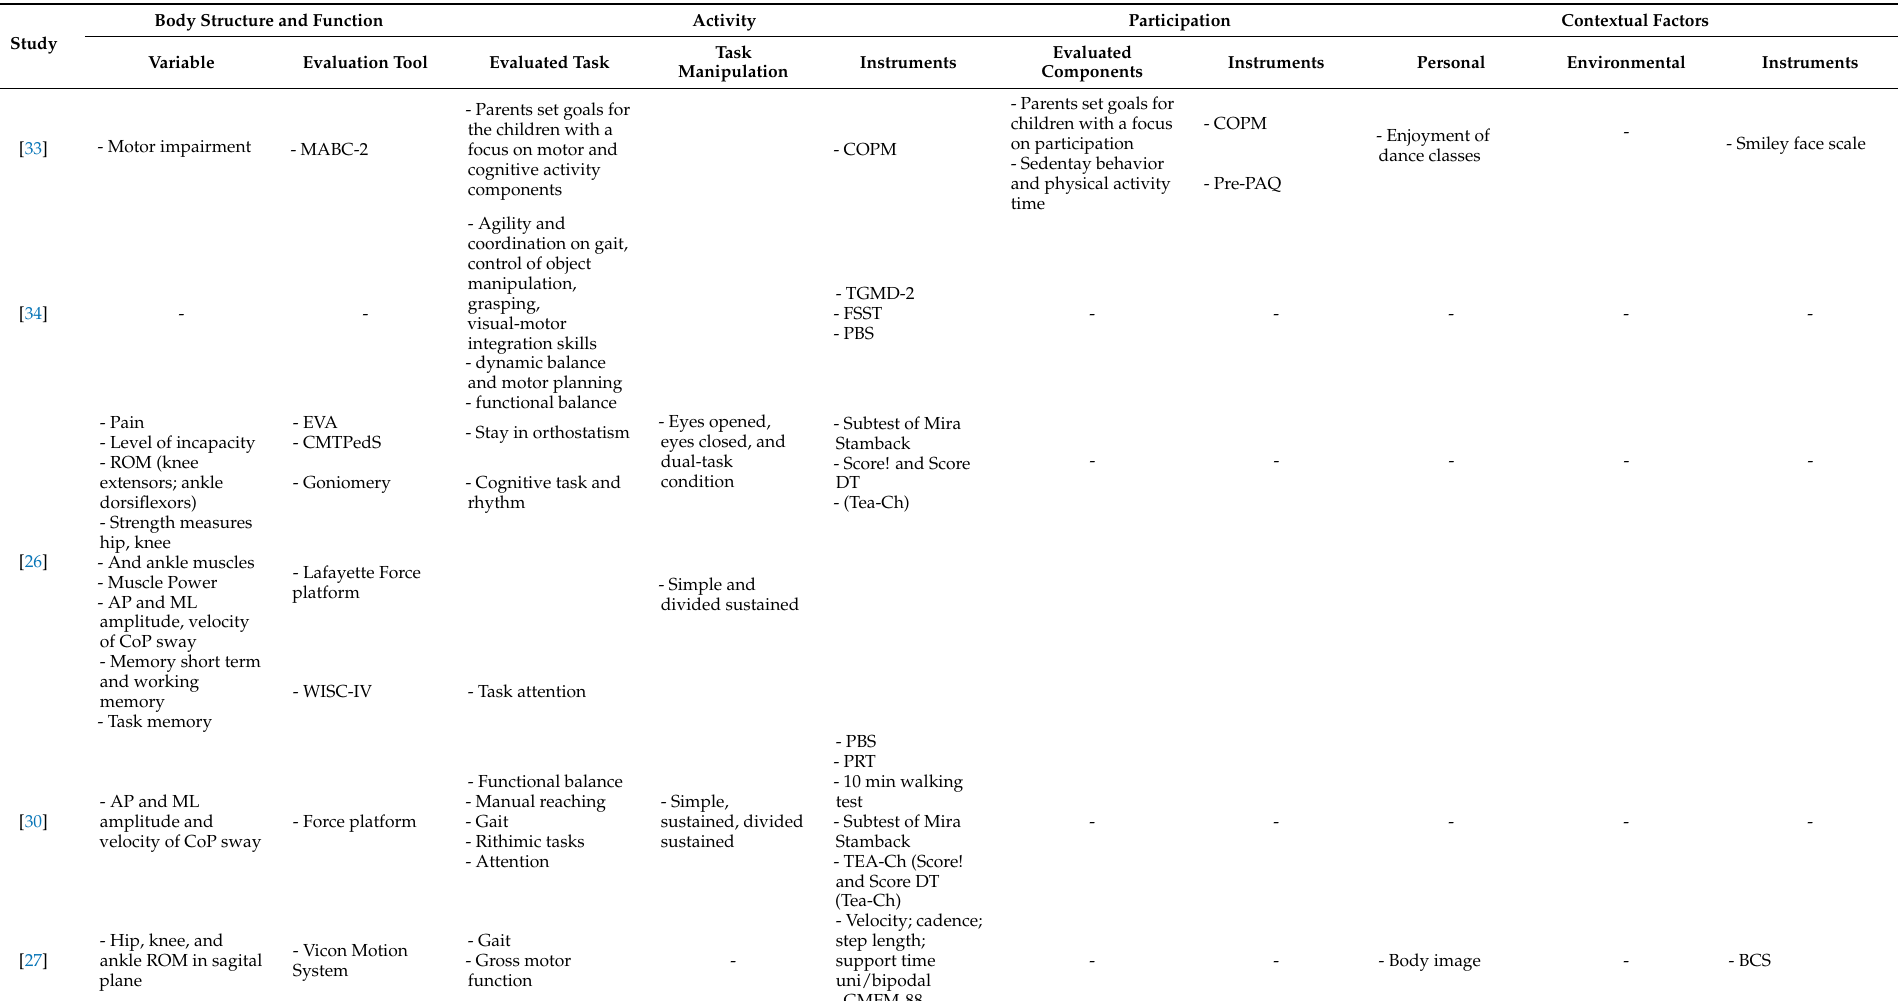
Table 2. Classification of Outcome Measures according to ICF